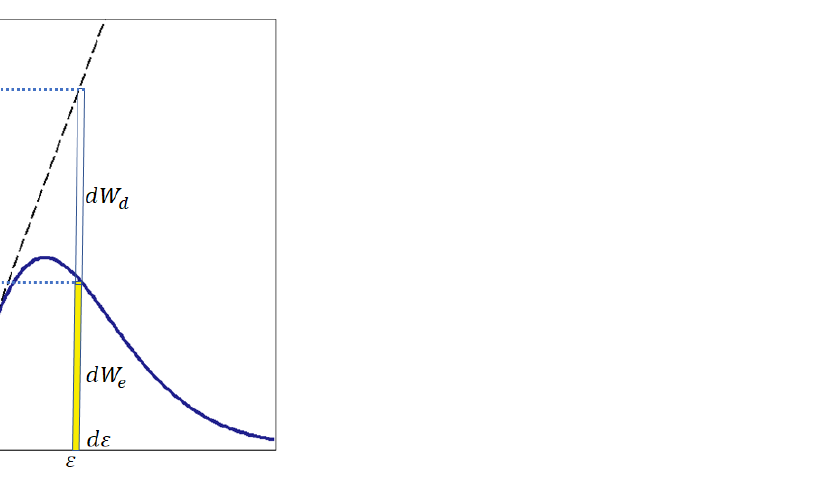
Figure 4. Strain energy dW e = σ d ε and dissipation energy dW d = ( ˆ σ − σ ) d ε . The stress in an ideal material without dissipation is ˆ σ = ε E tangential . The voltage σ in a material with energy dissipation is determined from Equation (5).